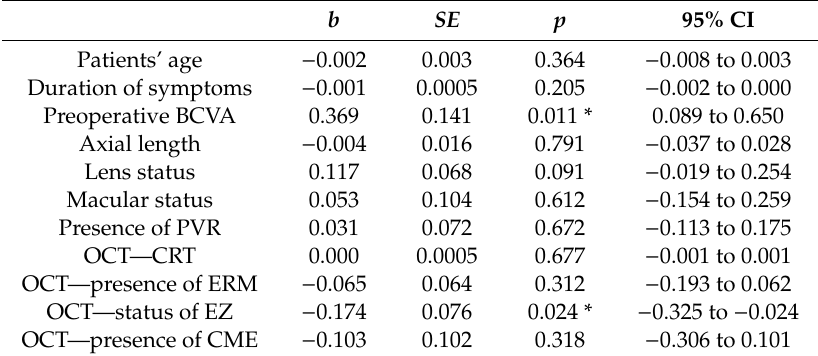
Figure 2. Postoperative OCT scan of a patient showing discontinuity of EZ. Table 6. The effect of preoperative factors and postoperative OCT macular findings on postoperative BCVA.